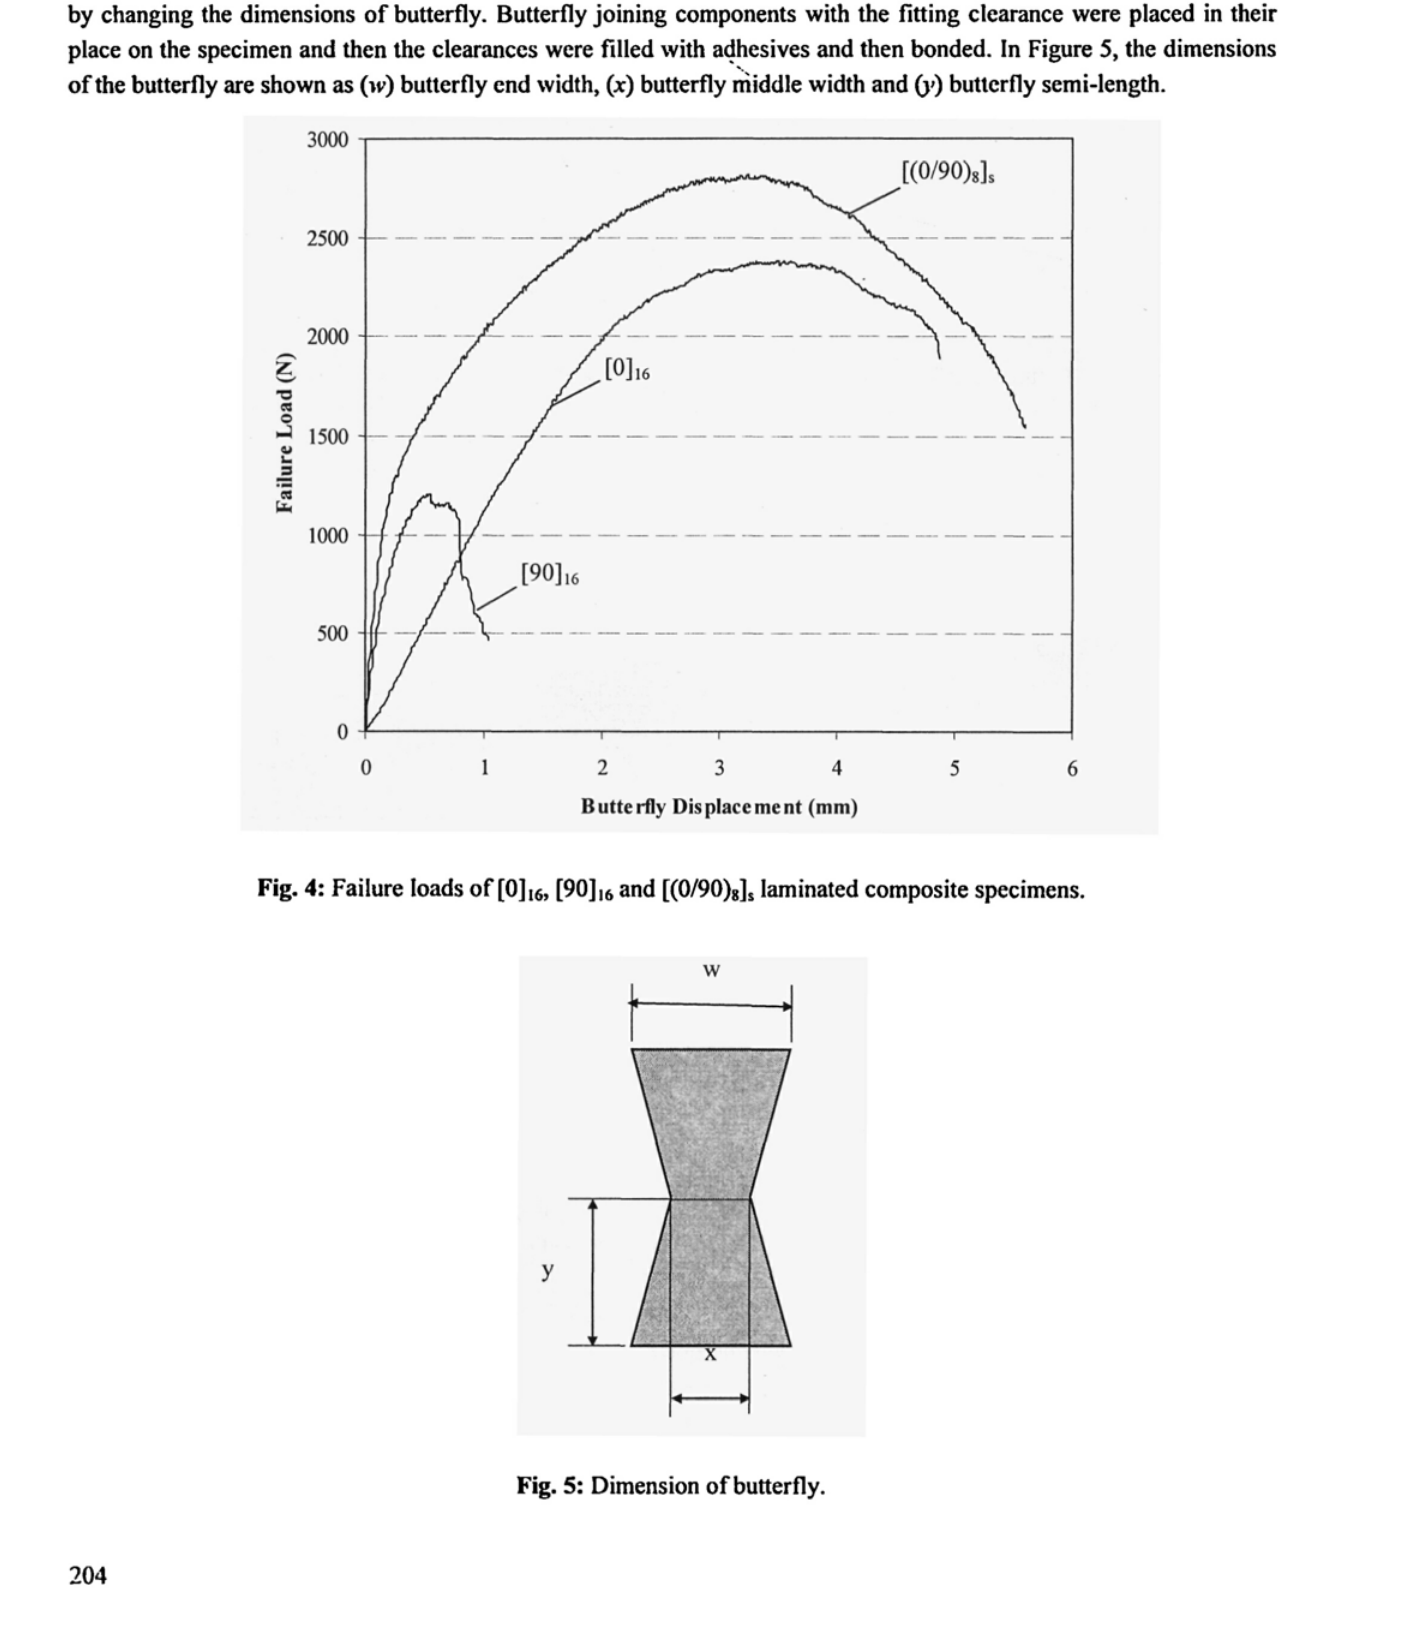
, [90], and [(0/90) 6 6